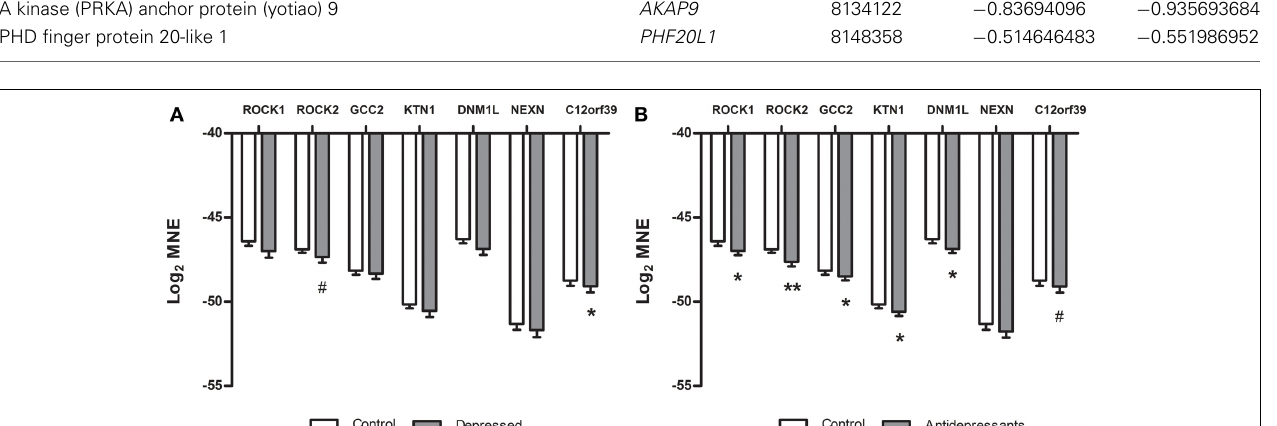
KTN1, DNM1L, NEXN , and C12orf39 genes in depressed (A) and SSRI women (B) . (A) ∗ P = 0 . 05, # P = 0 . 08, (B) ∗ P ≤ 0 . 05, ∗∗ P < 0 . 01, # P = 0 .